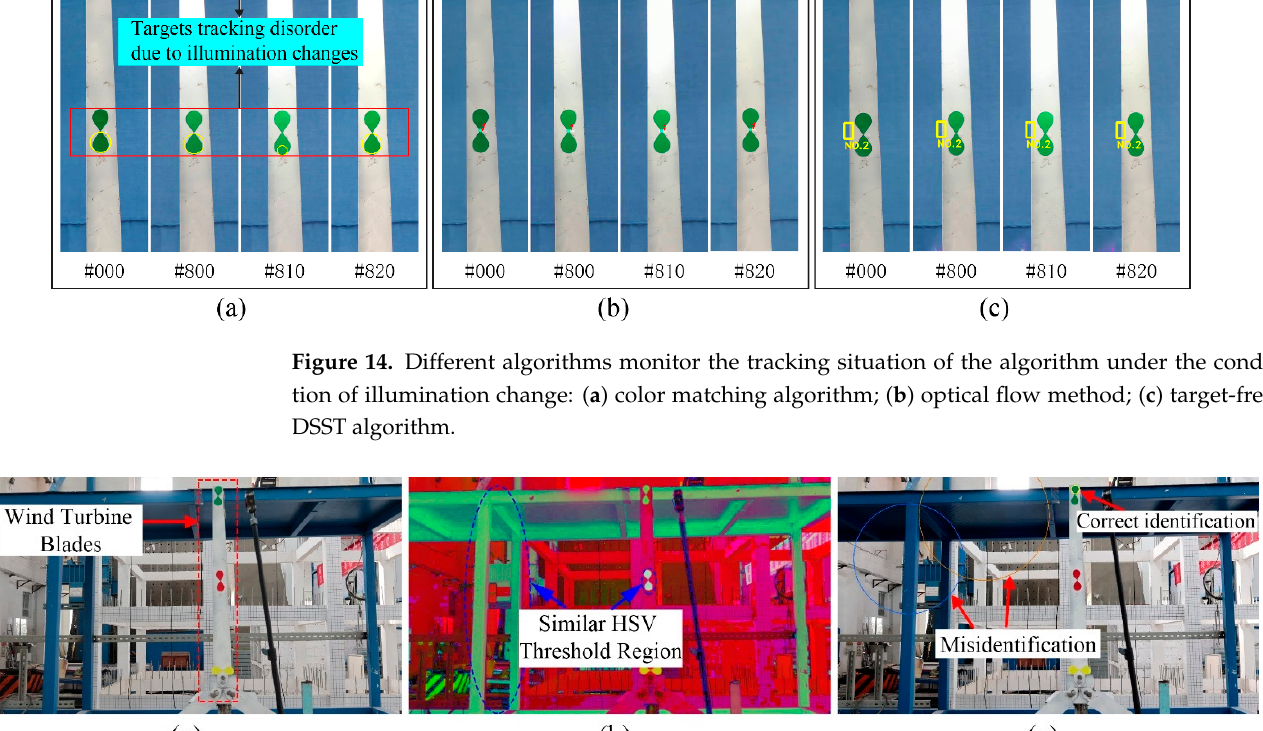
Figure 15. Monitoring effect of the color matching algorithm with a complex background: ( a ) wind turbine blade under complex background; ( b ) HSV color model image effect; ( c ) actual monitoring effect of the color matching algorithm.